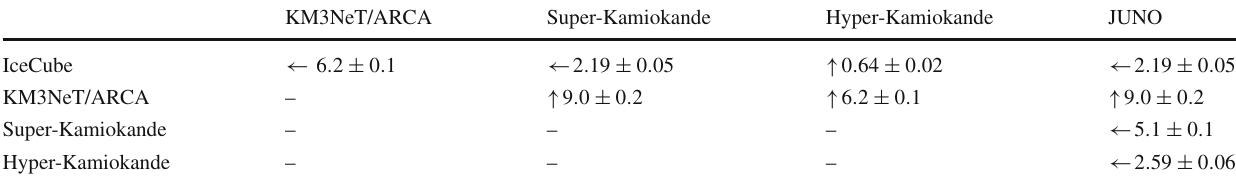
Table 4 Uncertainty δ t in milliseconds obtained with the cross-correlation method using the zero-normalisation. The detector pairs are listed in row and column names. The arrows point to the detector name that is used for the light-curve peak definition